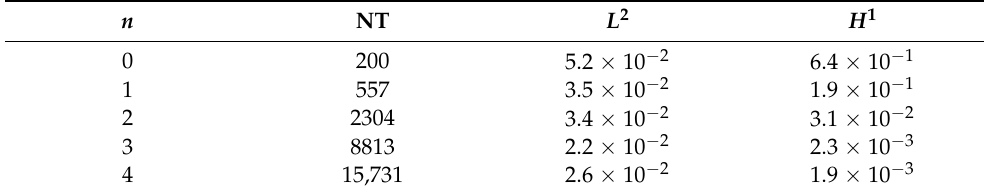
Table 11. Error in L 2 norm and H 1 seminorm for example 4 obtained with η Z .